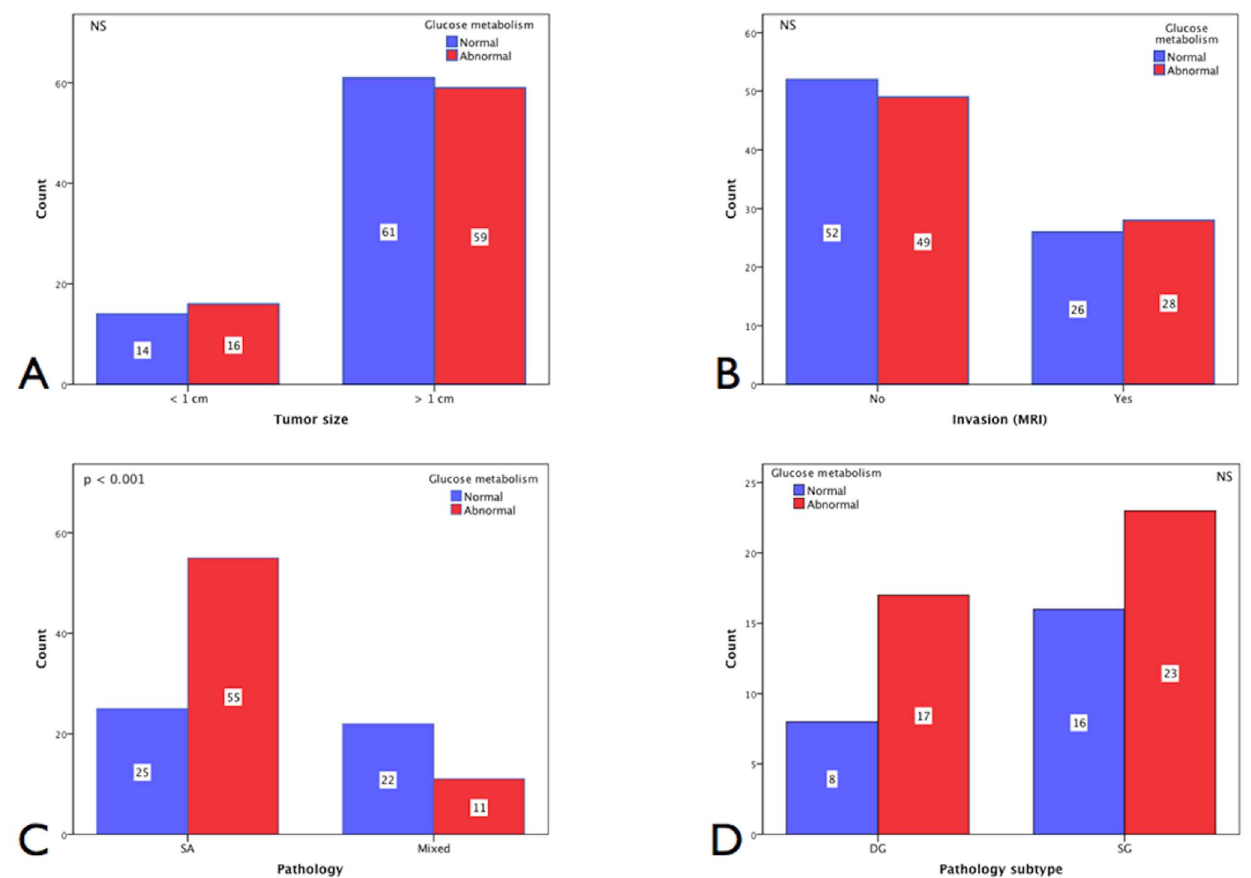
Figure 2. Baseline glucose metabolism status and pituitary tumor characteristics. A . Glucose metabolism status at presentation according to tumor size. Fourteen [9.3%] of patients with microadenomas and 61 [40.7%] with macroadenomas presented with normal glucose metabolism vs. 16 [10.7%] with microadenomas and 59 [39.3%] with macroadenomas revealed abnormal glucose metabolism at presentation [N=150] (NS). B. Glucose metabolism status according to invasion (MRI) revealed that 52 [33.5%] non-invasive and 26 [16.8%] of invasive cases presented with normal glucose metabolism vs. 49 [31.6%] non-invasive and 28 [18.1%] invasive with abnormal metabolism [N=155] (NS). C. Glucose metabolism status according to pituitary tumor pathology revealed that 25 [22.1%] of patients with pure SA and 22 [19.5%] with mixed adenomas presented with normal glucose metabolism compared to 55 [48.7%] with pure SA and 11 [9.7%] with mixed adenomas who presented with abnormal glucose metabolism [N=113] (p , 0.001). D. Glucose metabolism status according to pituitary pathology subtype revealed that 8 [12.5%] DG and 16 [25.0%] SG presented with normal glucose metabolism vs. 17 [26.6%] DG and 23 [35.9%] SG already had abnormal glucose metabolism [N=64] (NS).